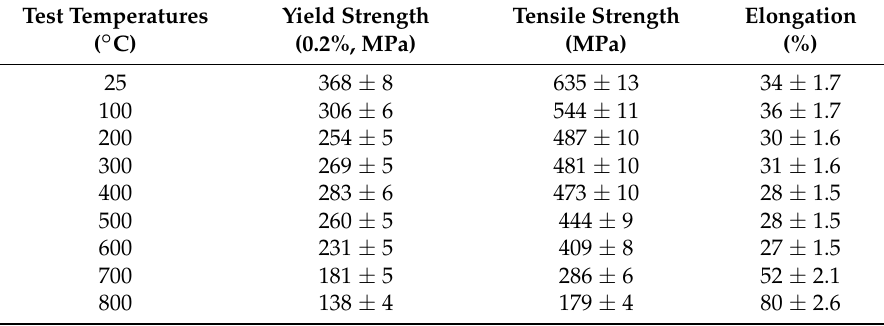
Table 4. Mechanical properties of as-welded blanks tested at temperatures of 200–800 ◦